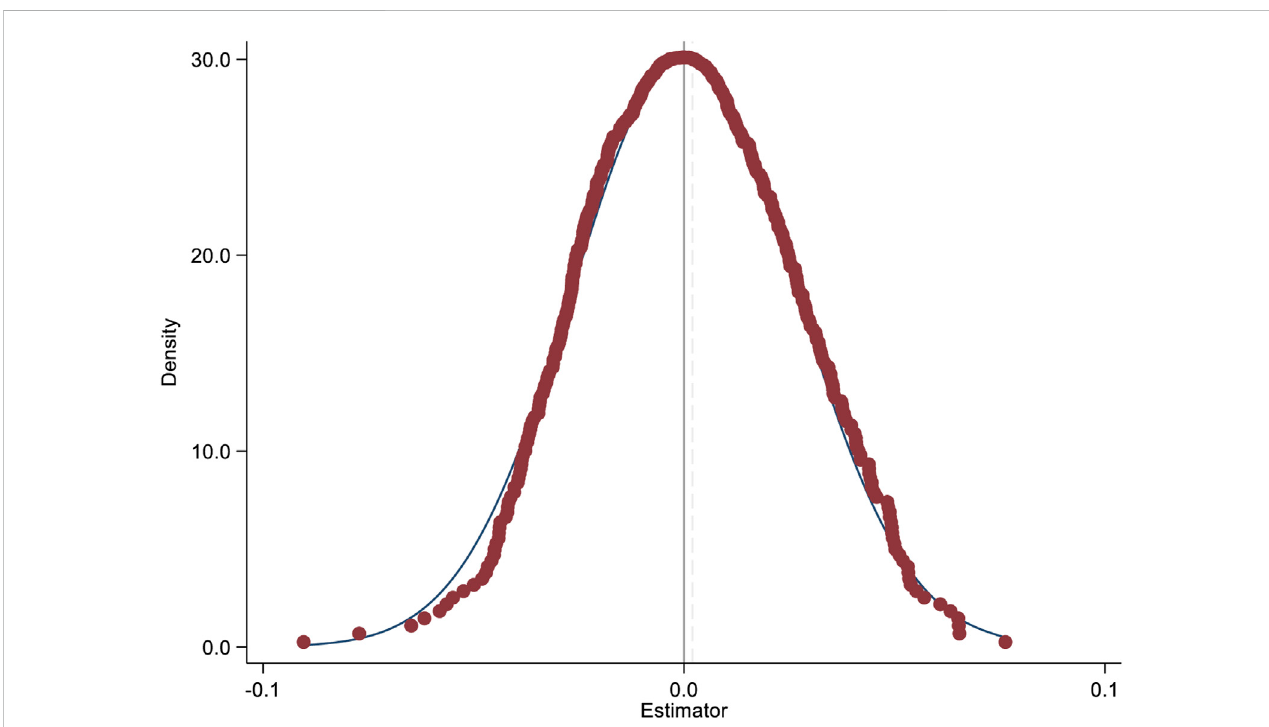
Results of placebo test. Treated group is randomly drawn 500 times in the control group by Monte Carlo simulation and DID regression was performed. Plot the obtained regression coef fi cients as a distribution graph. This fi gure reports the results of PM 2.5 concentration of cities without environmental information disclosures as a dependent variable, presenting a normal distribution with an average value of